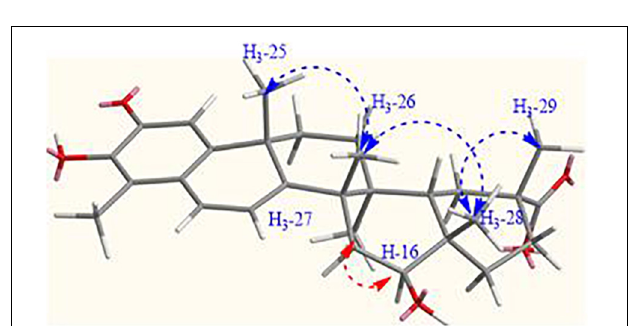
FIGURE 2 | Key 1 H– 1 H COSY (—) and HMBC (H → C) correlations of compounds 2 – 4 . HMBC correlations for determining differential structure fragments to compound 1 were assigned in red arrows, while the same correlations were assigned in blue arrows.